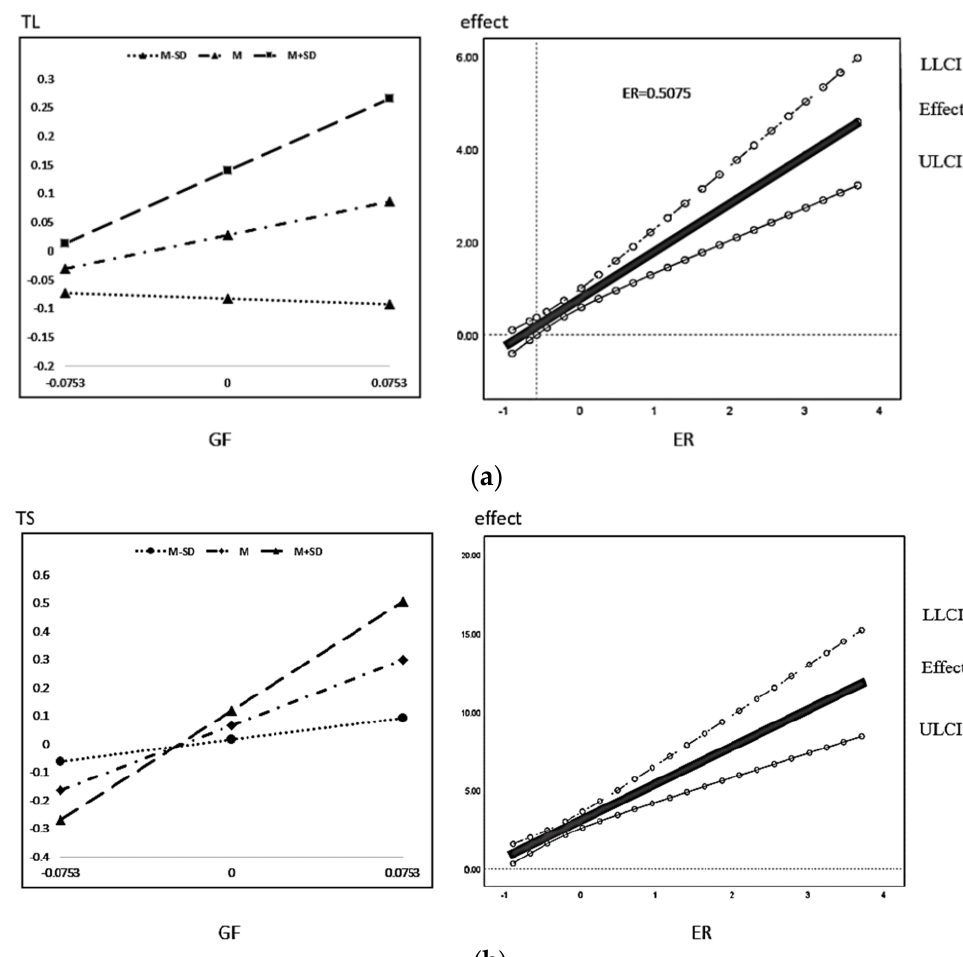
Figure 4. Total effect of green finance on economic quality development under the role of environ- mental regulation.